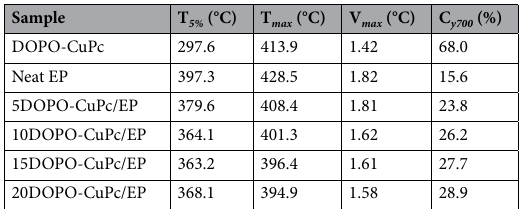
Table 2. TGA Data of epoxy thermosets under nitrogen.